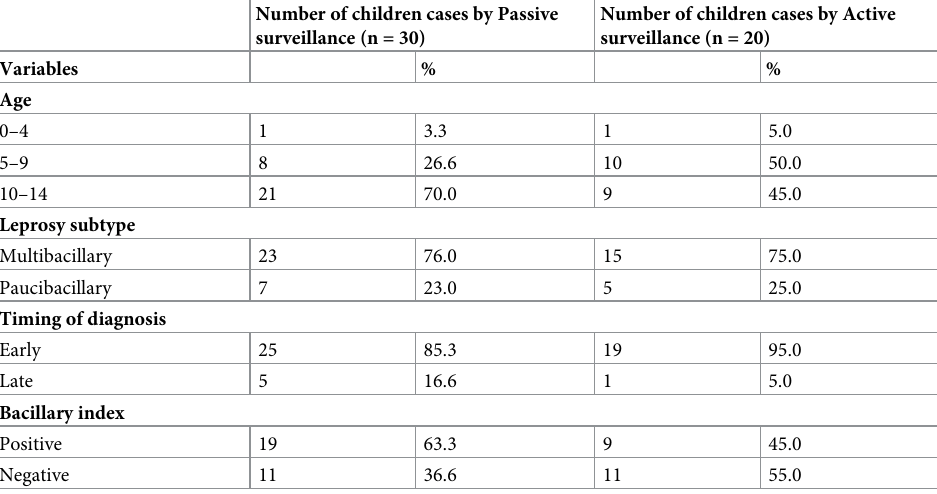
Table 6. Distribution of some variables according to the surveillance method.